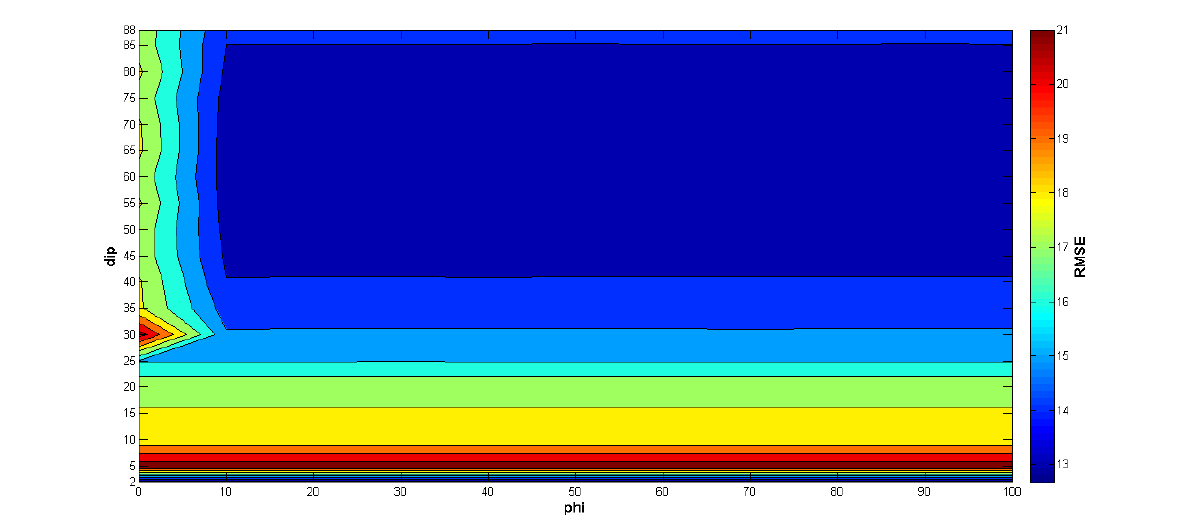
Figure 3.The graph represents the computed RMS of the differences between the models obtained from different amount of two parameters (dip angle and locking rate) and GPS observation. Vertical and horizontal axises respectively represent dip angle and locking rate. The lowest value of RMS will give us the optimum value of dip angle parameter that it is 2 degree. Also the graph shows the model is not sensitive to the locking rate but definitely shows the Makran subduction layer in